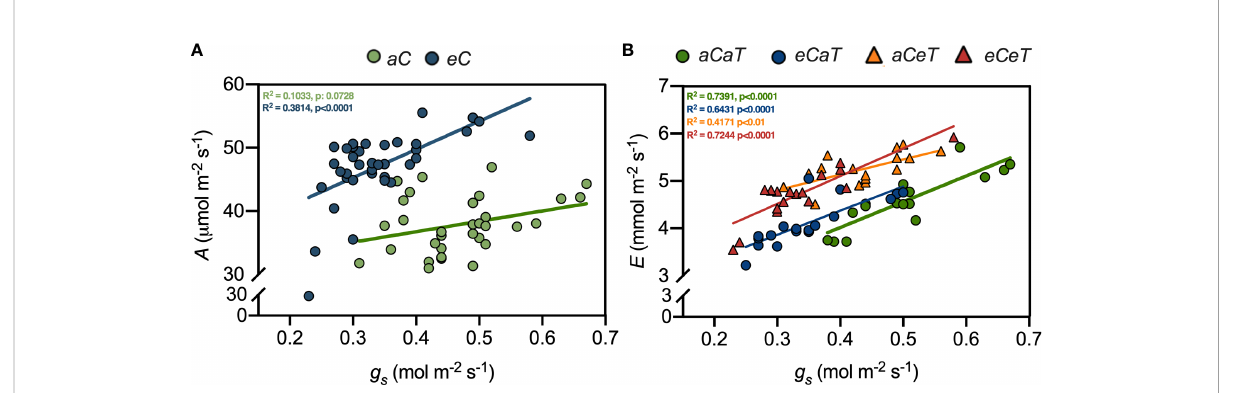
FIGURE 2 Linear regressions between leaf gas exchange parameters measured in fully expanded leaves of M. maximus at different levels of [CO 2 ] and temperature. A = net photosynthesis rate. g s = stomatal conductance. E = transpiration rate. R 2 and p-values are shown for each regression line according to the color of each treatment. (A) Equations: aC = Y = 16,40*X + 30,19, eC = Y = 44,53*X + 31,92. (B) Equations: aCaT = Y = 5,437*X + 1,843, eCaT = Y = 5,100*X + 2,334, aCeT = Y = 3,237*X + 3,837, and eCeT = Y = 5,845*X + 2,763. Regressions were performed using the raw data from Habermann et al. (2019). Treatments: aC (ambient CO 2 concentration), eC (elevated CO 2 concentration – 600 ppm), aT (ambient temperature), and eT (elevated temperature - 2°C above ambient temperature).